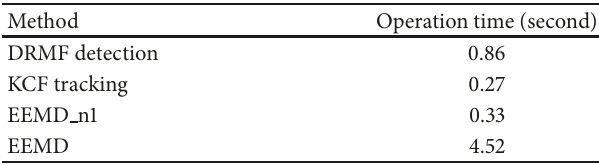
Table 3: The time it takes to operate once for each